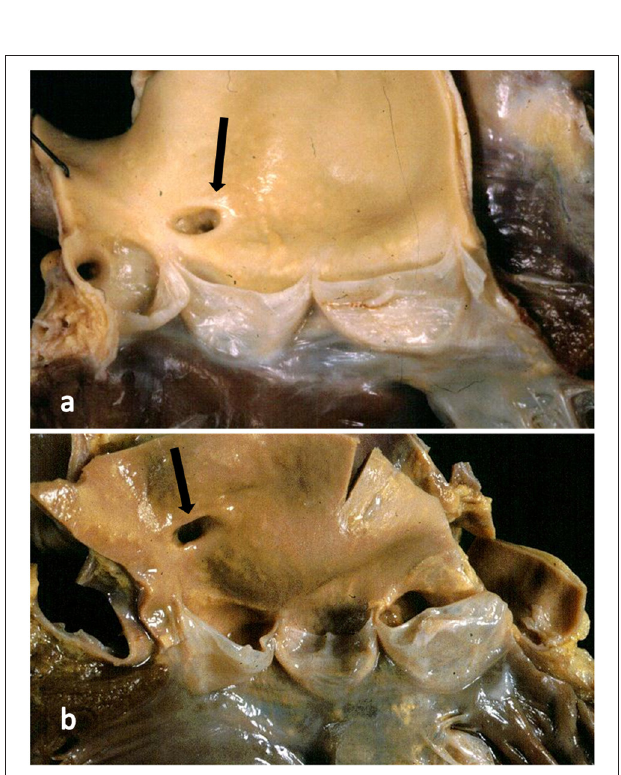
FIGURE 4 | (a) The right coronary artery orifice (arrow) is just above (2mm) the sinotubular junction, within normal limits. (b) The right coronary orifice (arrow) is well above the sinotubular junction (10mm), over the threshold of normal limits.